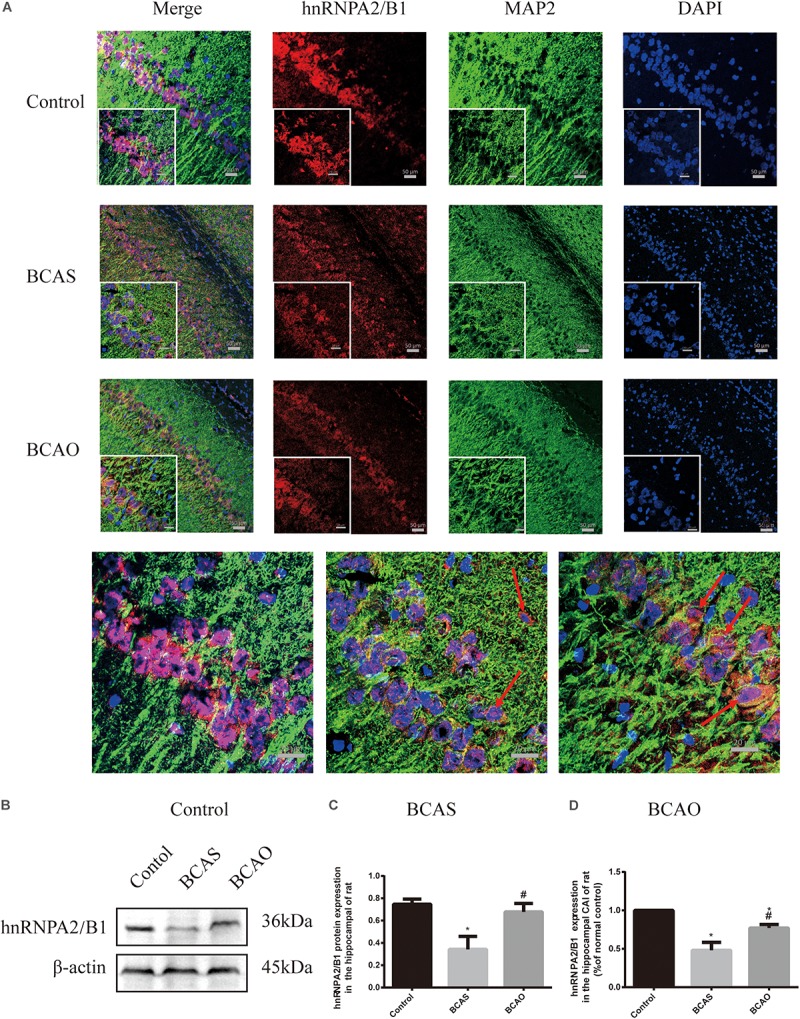
Expression of hnRNPA2/B1 at 30 days after surgery. Protein detected by immunofluorescence in the hippocampal CA1 region (A and C). Hippocampal hnRNPA2/B1 expression detected by western blotting (B and D). Data are expressed as the mean ± SD (n = 6/group). ∗P < 0.05 compared with the control group; #P < 0.05 compared with the BCAS group; BCAS, bilateral common carotid artery stenosis; BCAO, bilateral common carotid artery occlusion; hnRNPA2/B1, heterogeneous nuclear ribonucleoprotein A2/B1; SD, standard deviation; MAP2, Microtubule associated protein 2; DAPI, 4’,6-diamidino-2-phenylindole.